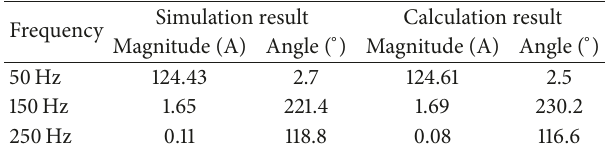
Table 2: Comparison of theoretical results and simulation results of harmonic currents on ac side.